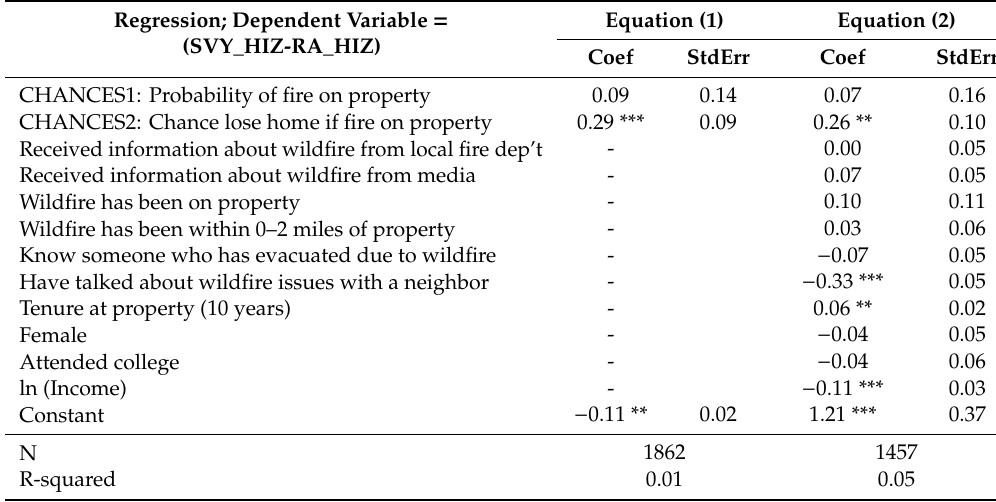
Table 3. Regression models of di ff erence ( = RA_HIZ-SVY_HIZ) between professional- and self-assessed HIZ conditions; higher values signify residents underestimating the HIZ-related vulnerability compared to the professional.